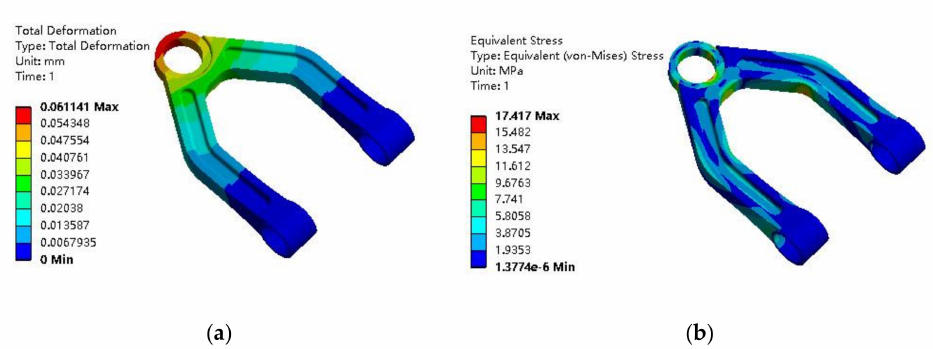
Figure 19. The finite element analysis (FEA) results of the initial model: ( a ) displacement distribution; ( b ) stress distribution.